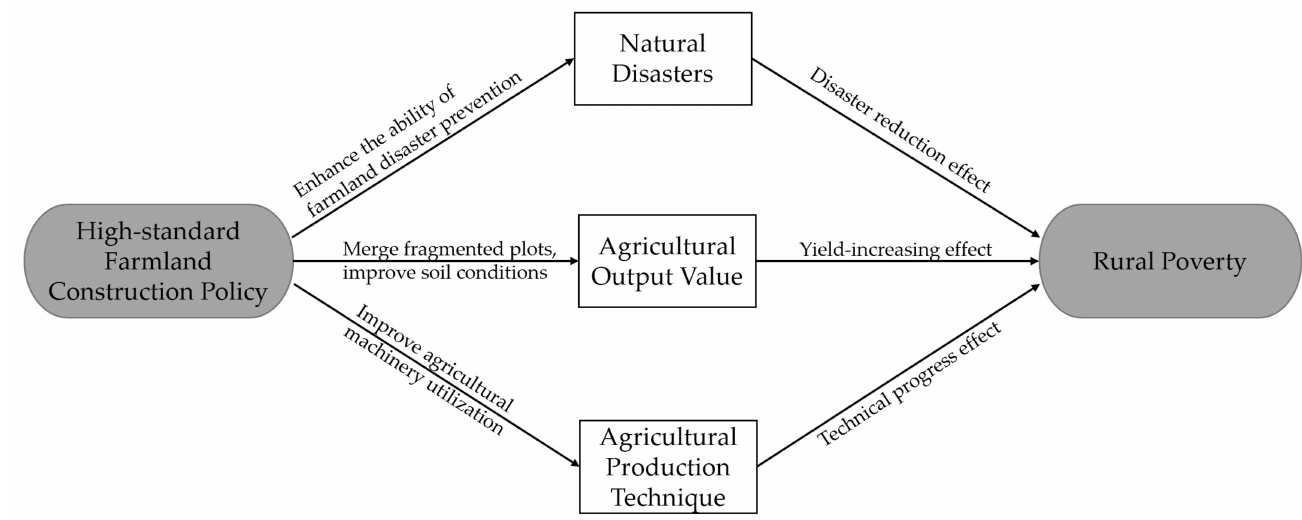
Figure 2. Poverty reduction mechanism of high-standard farmland construction